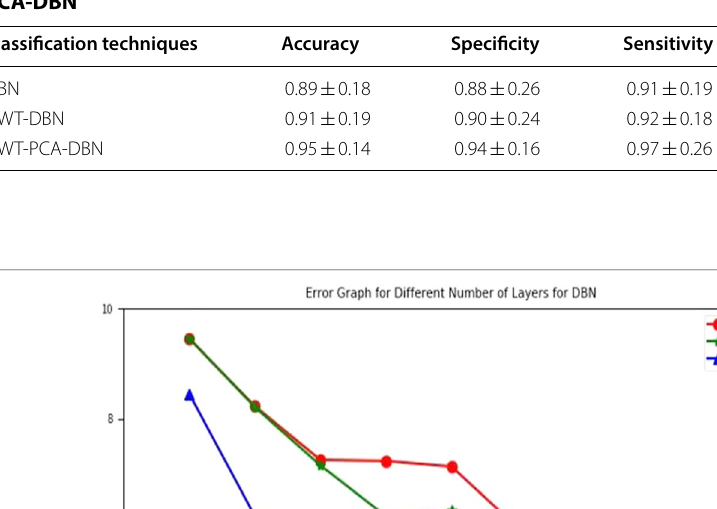
Table 3 Performance comparison between traditional DBN, DWT-DBN and proposed DWT-